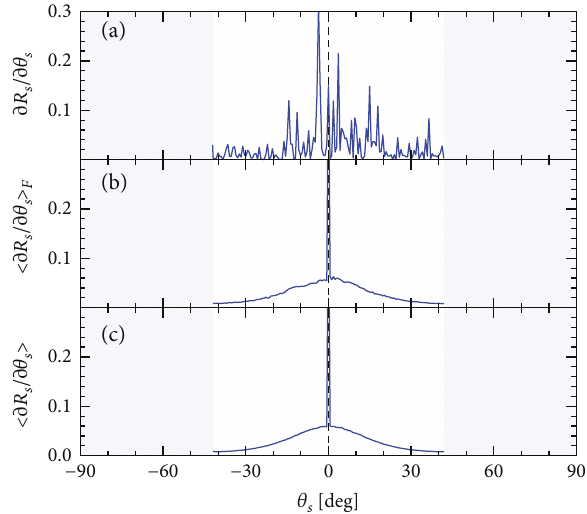
= 2 25 and ε = 1 ) but assuming s- 1 2